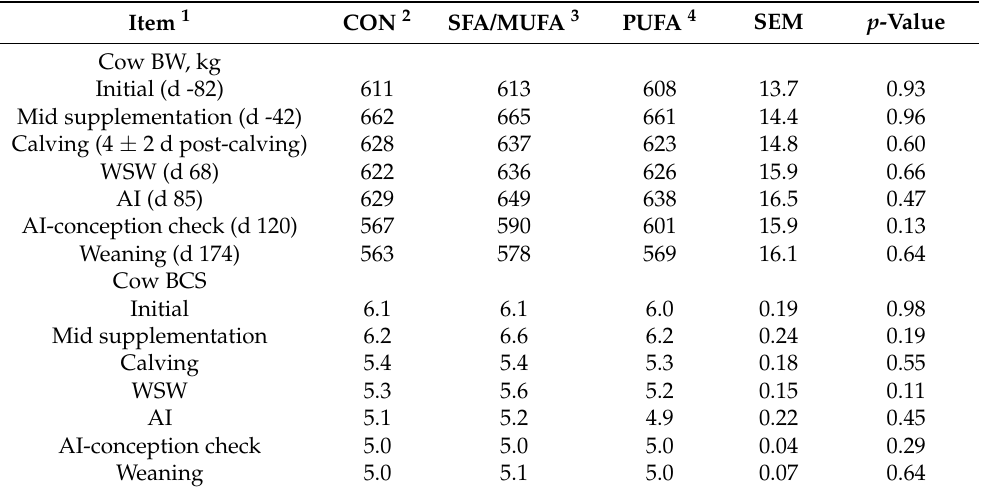
Table 6. Effects of supplementation for the last 82 ± 5 d of gestation of soybean hulls mixed with either whole-shelled corn (CON), Ca salts of saturated/monounsaturated fatty acids (SFA/MUFA), or Ca salts of polyunsaturated fatty acids (PUFA) on cow body weight and body condition score 1 . Item